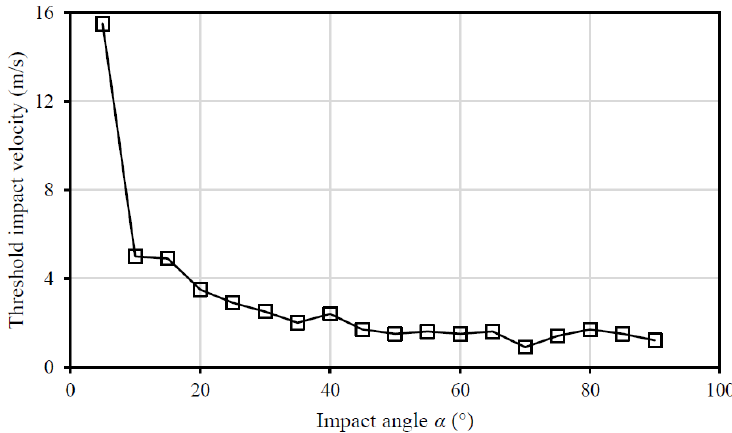
Figure 23. The threshold impact velocity for creating through-thickness bending cracks.